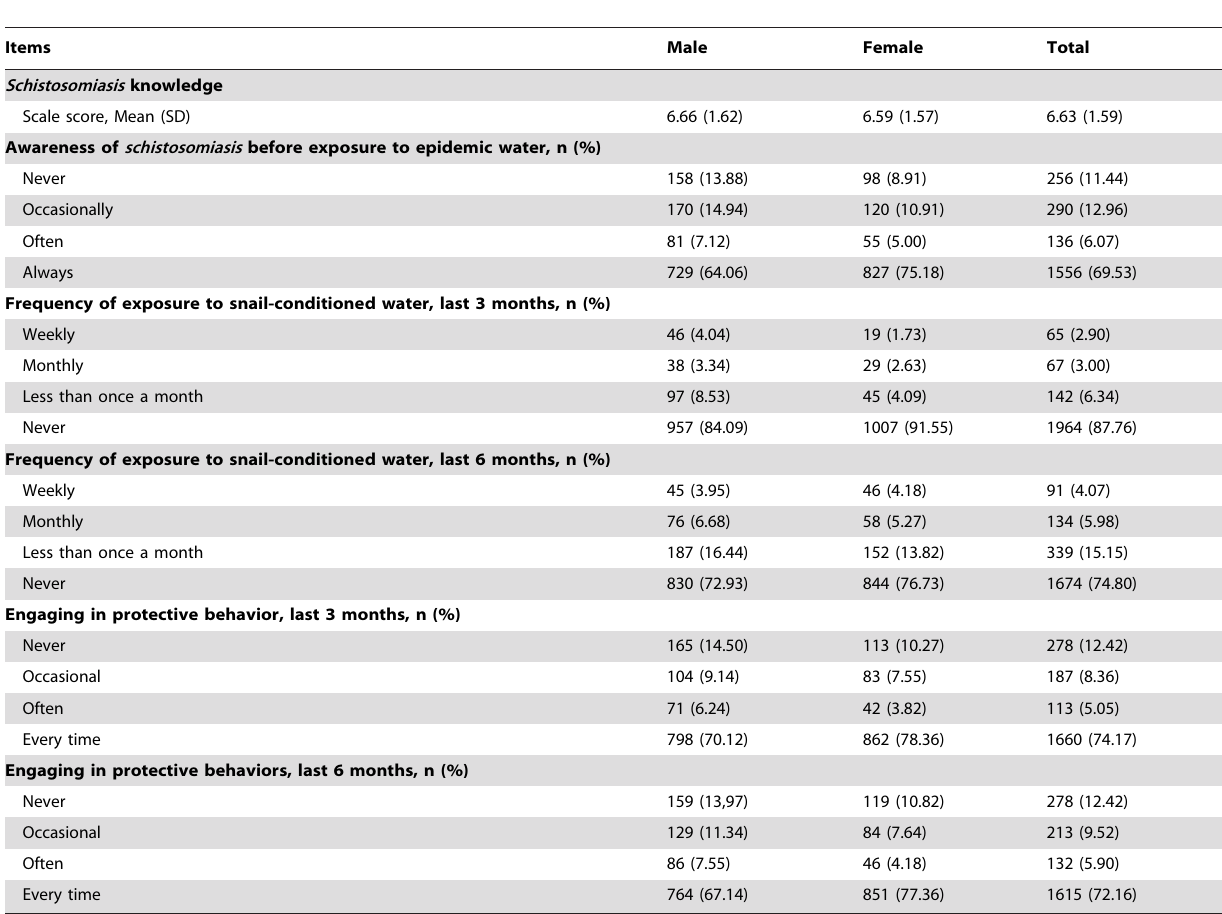
Table 2. Knowledge and awareness of schistosomiasis and exposure to snail-conditioned